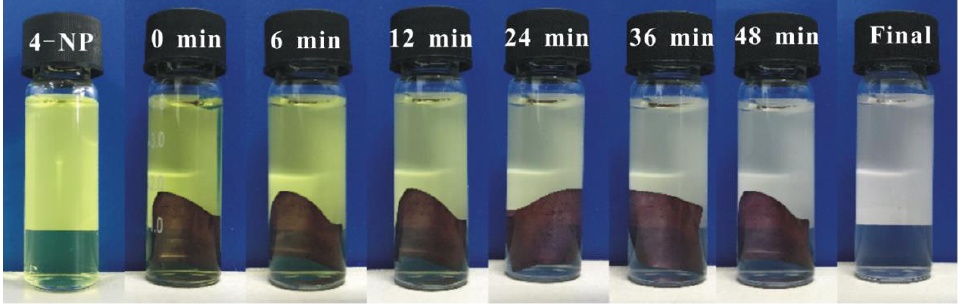
Figure 6. AuNPs/BC-poly(HEMA) in the 4-NP solution at different time intervals. Figure 6. AuNPs / BC-poly(HEMA) in the 4-NP solution at di ff erent time